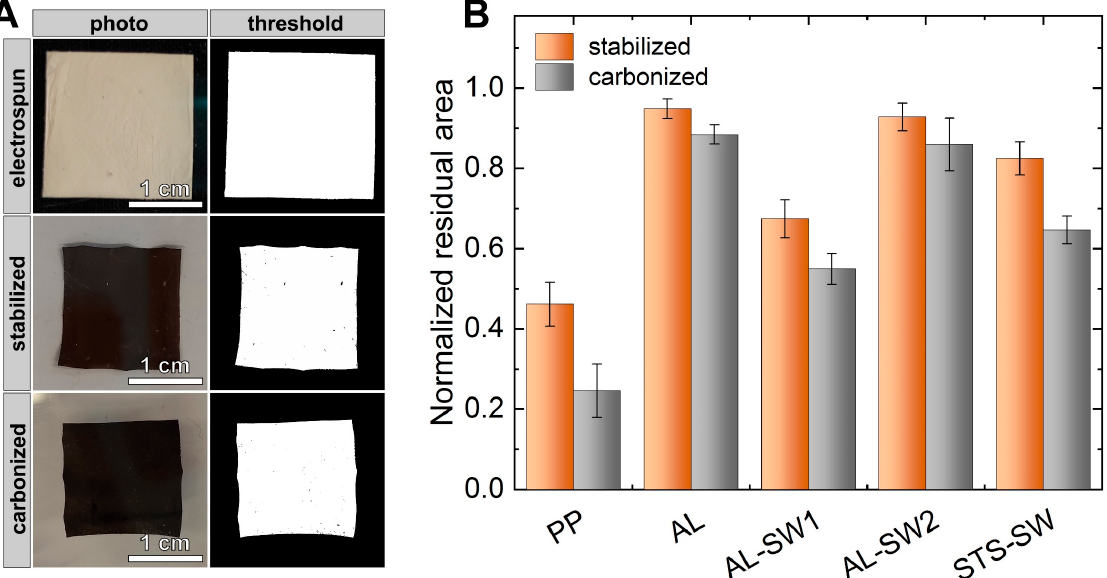
Figure 3. Area evaluation of heat-treated nanofiber mats: ( A ) exemplary procedure for the determination of the residual area and ( B ) normalized residual areas determined after stabilization and carbonization.